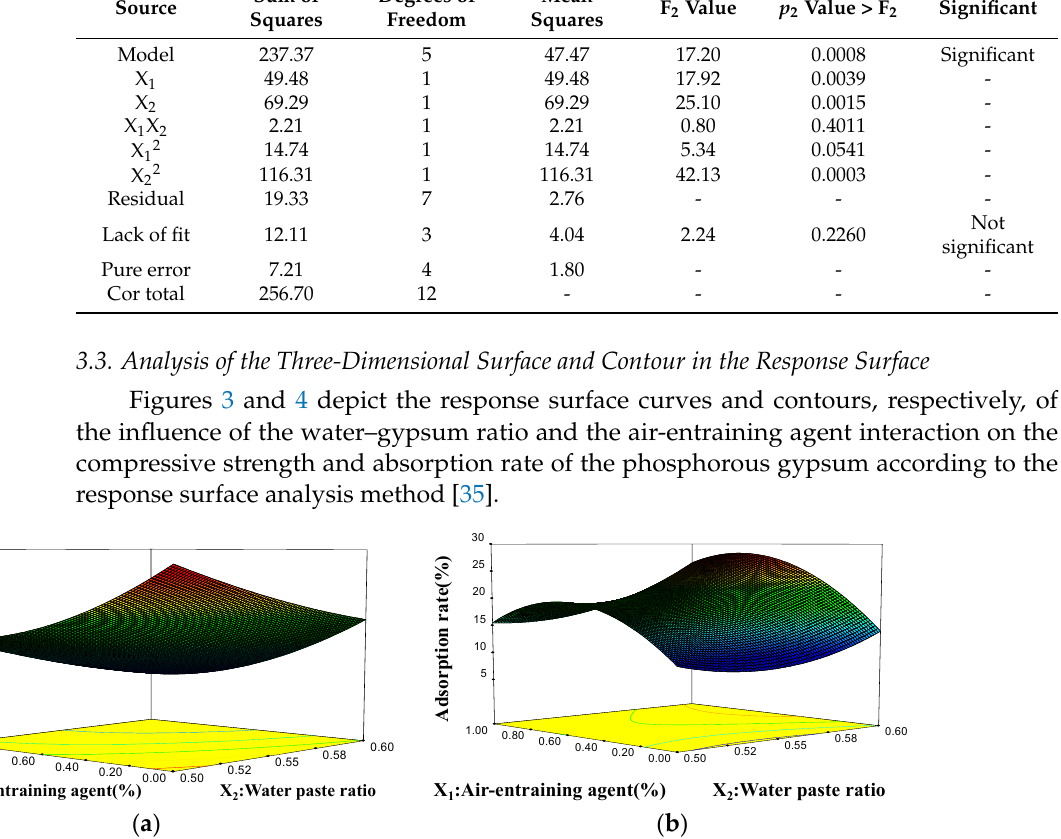
Figure 4. Response surface contours of the influence of the water–paste ratio and the air-entraining agent interaction on the ( a ) compressive strength and ( b ) absorption rate of the phosphorous gypsum.